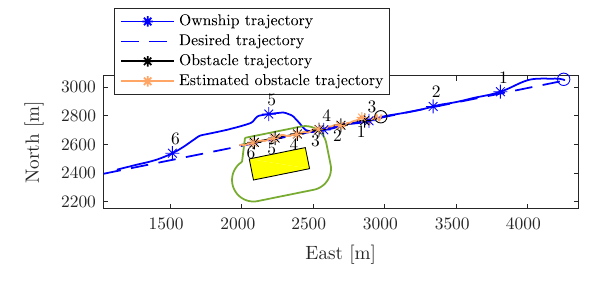
Figure 13: Scenario 4: Overtaking situation. The ownship overtakes the OSD1 by passing on the starboard side, while avoiding the static obstacle. The cir- cles denote the initial positions, while the num- bers and asterisks mark each 60 s of the experi- ment. The yellow patch shows the static obsta- cle, while the dark green contour line shows the padding region. Table 3: Minimum distance to obstacles. *The padding dis- tance in Scenario 2 is 50